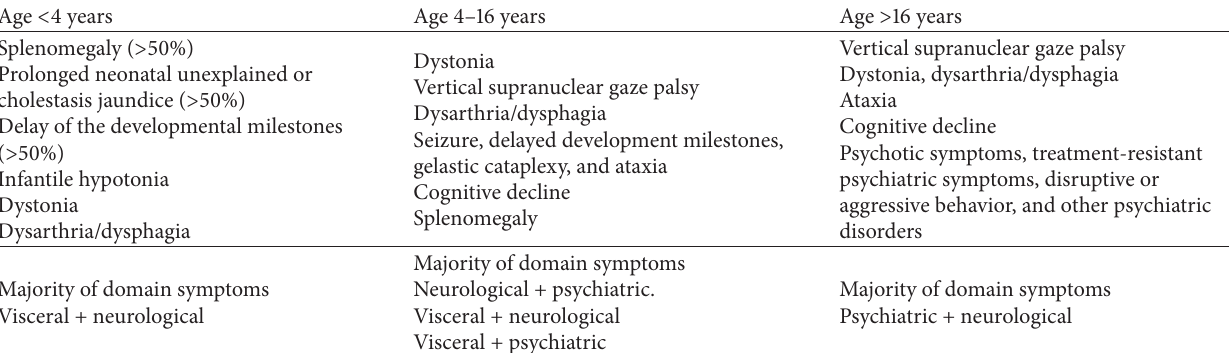
Table 3: Manifestations of NP-C disease by age group [10].